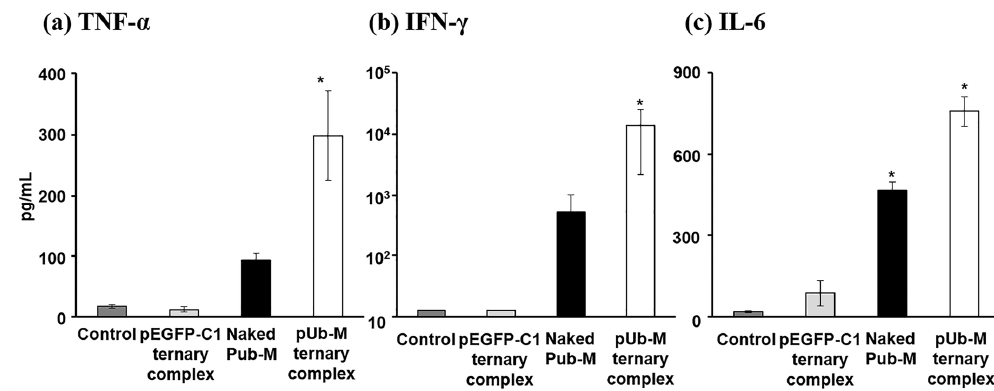
Figure 5. Cytokines secreted from splenic cells of immunized mice. Melanoma-stimulatory cytokine secretion characteristics by DNA vaccination using the complex constructed with pUb-M. Cancer cell lysate-specific IFN- γ , TNF- α , and IL-6 secretion from splenic cells immunized three times biweekly with control, naked pUb-M, the pUb-M ternary complex (50 µg of pDNA), or pEGFP-C1 ternary complex (50 µg of pDNA). Splenic cells (5 × 10 5 cells) were collected two weeks after the last immunization. After immunized splenic cells were cultured for 72 h in the presence of a cancer cell lysate (5 × 10 4 cells), IFN-γ, TNF-α, and IL-6 secreted in the medium were measured by ELISA. Each value represents the mean ± S.E. ( n = 3). * P < 0.05, vs. control.